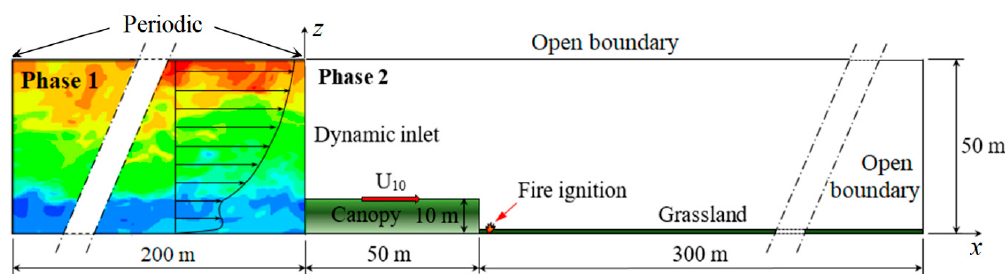
Figure 3. 2D view of the computational domain and boundary conditions used for phase 2. Domain width is 50 m in the y -direction with periodic boundary conditions.